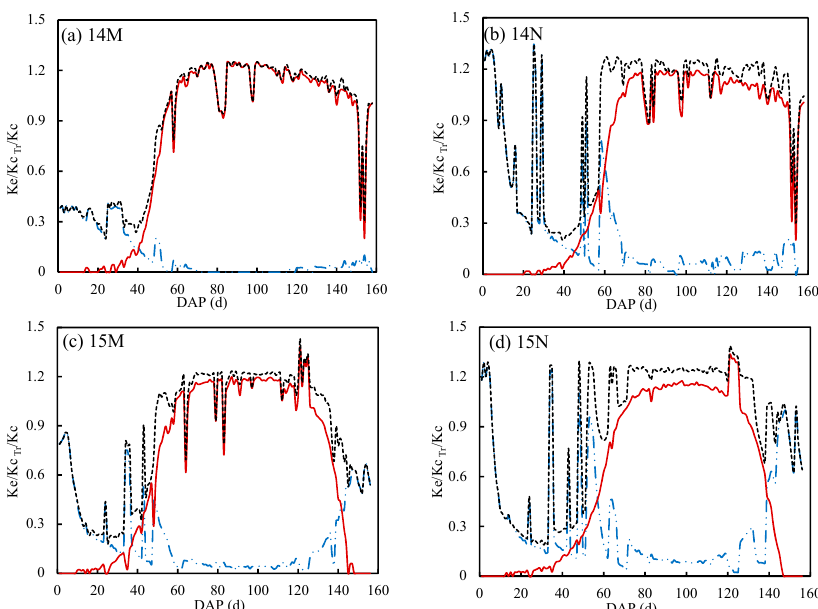
Figure 6. Variations in daily crop coefficient components against DAP of seed maize partitioned for treatments with and without plastic film mulch (M and N) in 2014 to 2015, including crop coefficient Kc (- - - - - - -), soil evaporation coe ffi cient Ke (– ·· – ·· – ·· –) and transpiration coe ffi cient Kc Tr (—). Table 5. Mean crop coe ffi cient Kc , transpiration coe ffi cient Kc Tr , soil evaporation coe ffi cient Ke of seed maize in di ff erent growth stages for treatments with and without plastic film mulch (M and N).